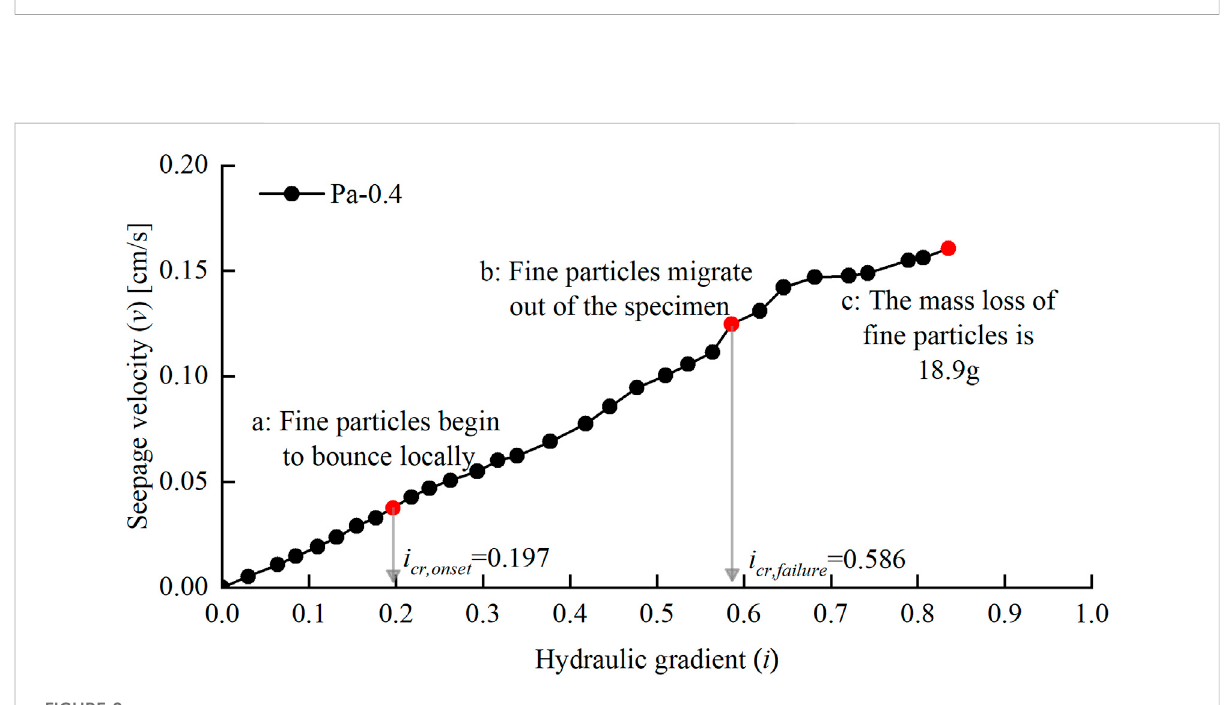
FIGURE 8 i – v curve for test